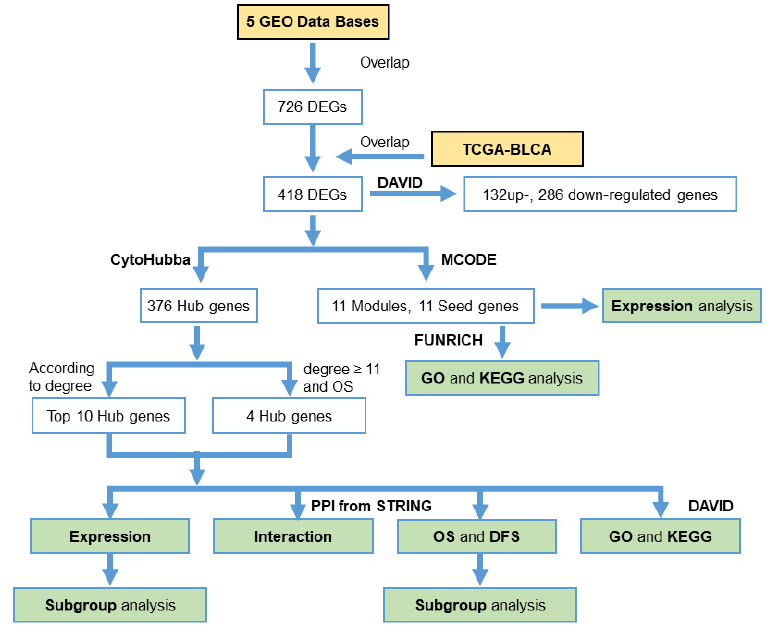
Figure 1. Study design. Workflow of the analysis steps and software used.